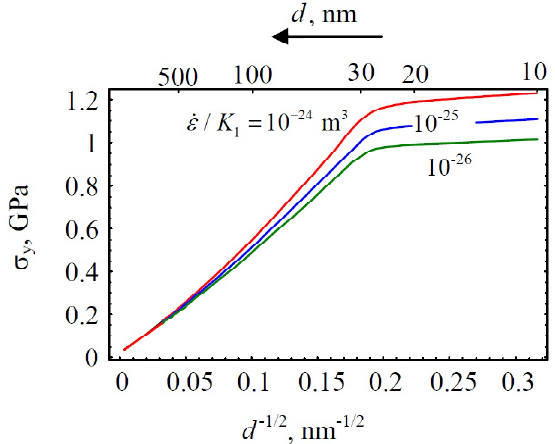
Fig. 2. The dependences of the yield strength  polycrystalline Cu on the inverse square root, d -1/2 , of grain size d , for various values of   / K